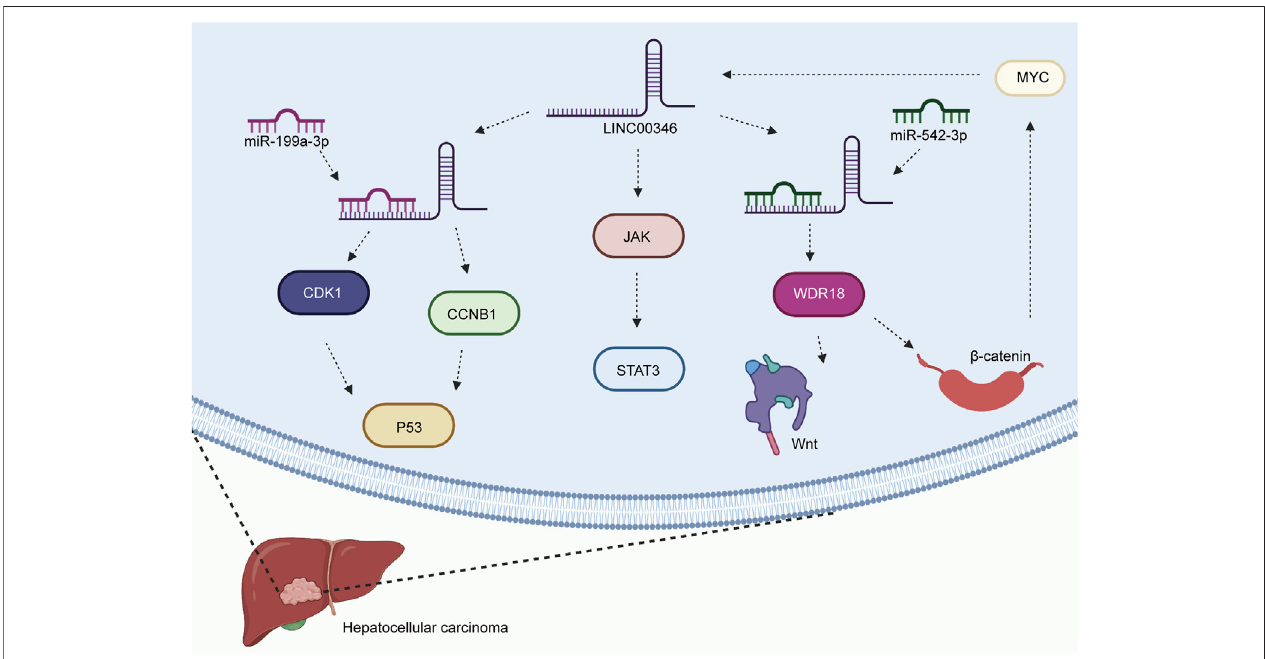
FIGURE 1 | Mechanisms of LINC00346 in HCC (HCC). LINC00346 upregulates the expression levels of CDK1 and CCNB1 by sponging miR-199a-3p in HCC. It attenuates cell invasion and apoptosis and to regulates the cell cycle by regulating p53 and the miR-199a-3p/CDK1/CCNB1 axis. LINC00346 facilitates WDR18 expression and activates the Wnt/ β -catenin pathway by acting as a sponge of miR-542-3p in HCC. β -catenin and LINC00346 form a positive feedback loop by interacting with MYC. Finally, LINC00346 affects cell proliferation and survival by activating the JAK-STAT3 signaling pathway.